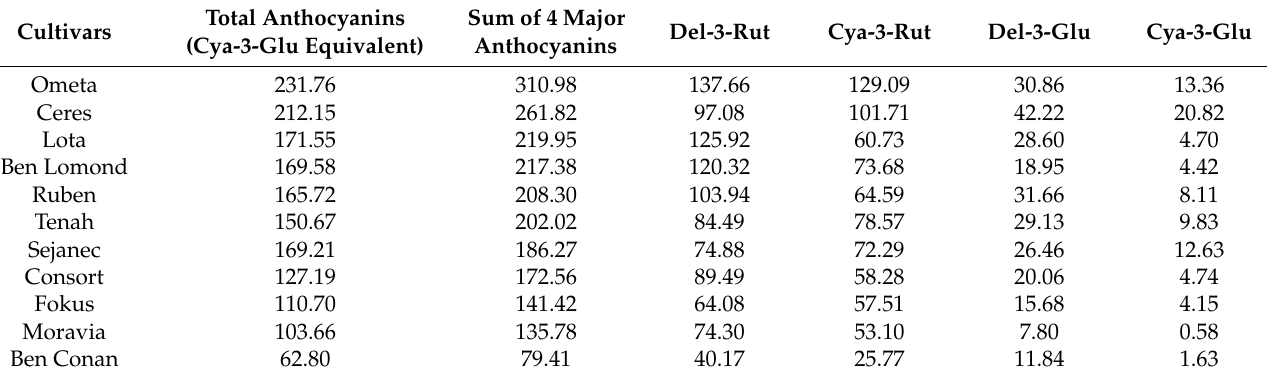
Table 2. Anthocyanin content (mg/100 g) in blackcurrant cultivars measured during the first year of the experiment— comparison of different evaluation approaches.